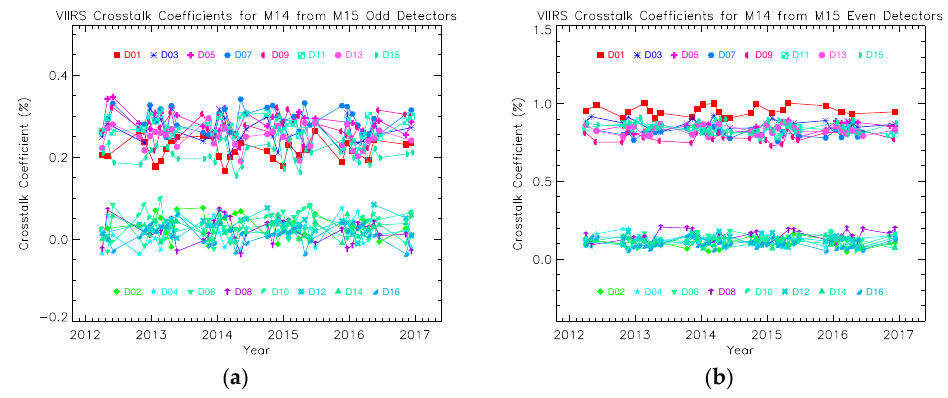
Figure 7. SNPP VIIRS Band M14 crosstalk coefficients for sending Band M15: ( a ) odd detectors and ( b ) even detectors.